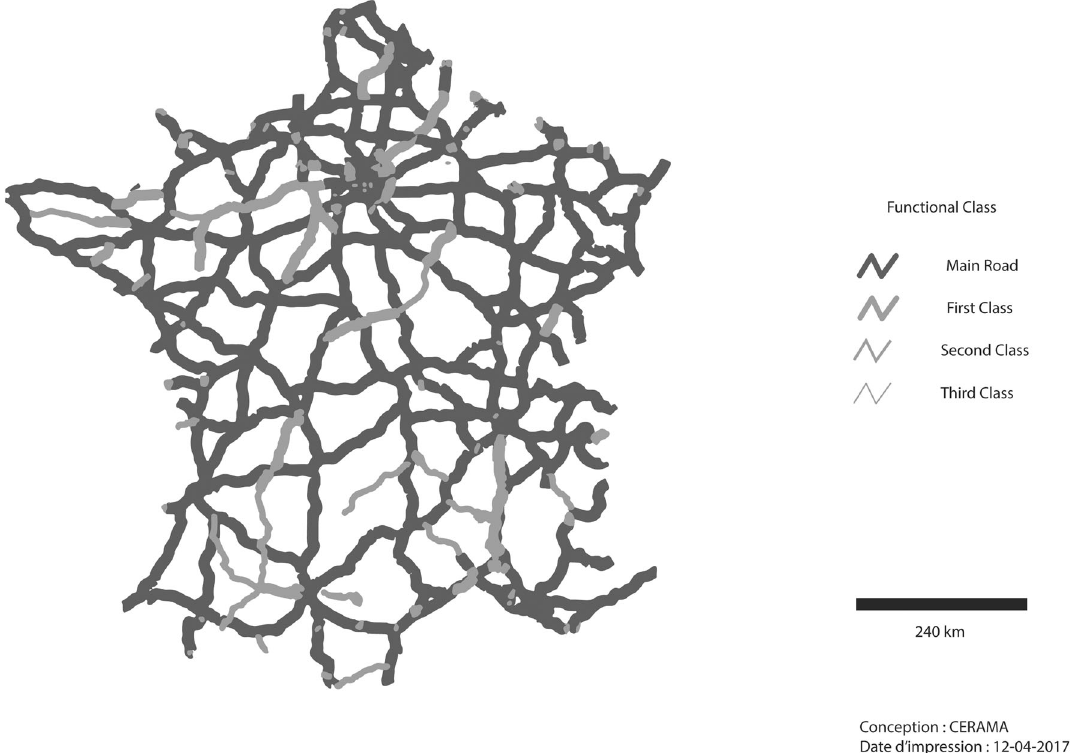
Cartelie software. Copyright Ministère de l ’ Egalité des territoires et